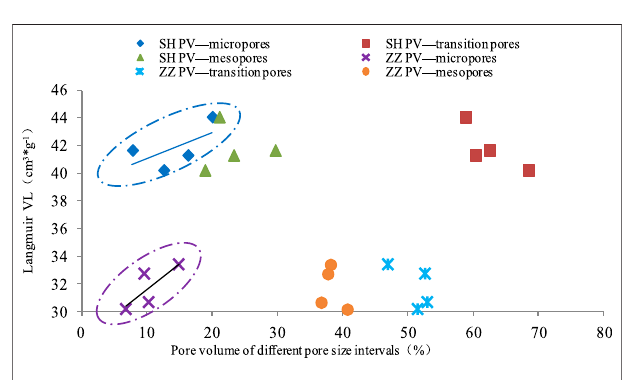
FIGURE 9 | Relationships between PV and V L of different pore